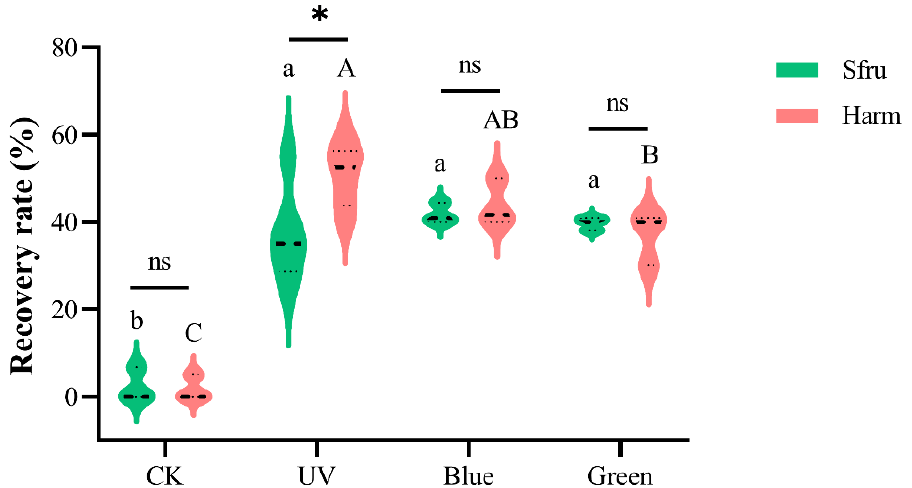
Figure 5. Phototactic recovery rates of S. frugiperda and H. armigera under indoor simulated conditions. The light intensity is 0.5 lx for three LED lights. Data are mean ± SE. Different letters of the same species indicate significant differences among different treatments ( p < 0.05, ANOVA). “*” indicates a significant difference between the two samples ( p < 0.05, t -test), while “ns” means not.